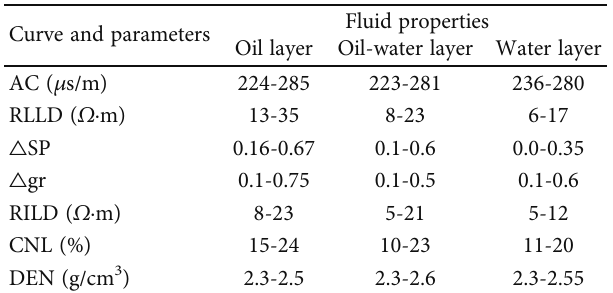
Table 1: Summary of logging response value range of oil layer, oil- water layer and water layer of Putaohua oil